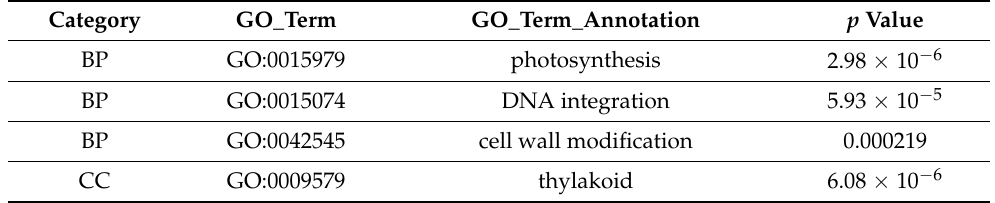
Table 4. Top ten significant GO terms of DG HP